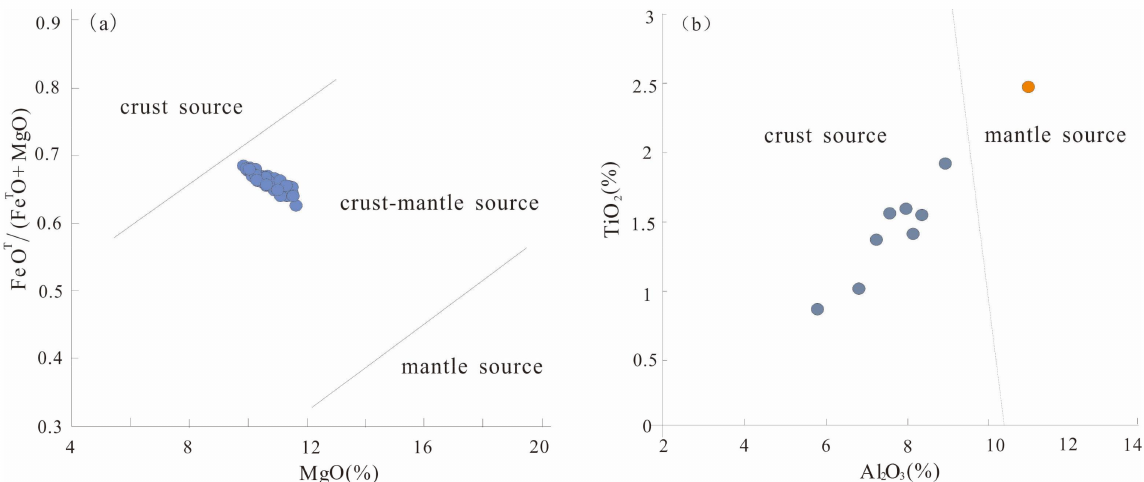
Figure 9. Diagram of Plot of FeO T /(FeO T + MgO) vs. MgO from biotites ( a ) and diagram of TiO 2 vs. Al 2 O 3 from amphiboles ( b ) (after Jiang and An, 1984 [79]; Zhou et al., 1986 [80]).